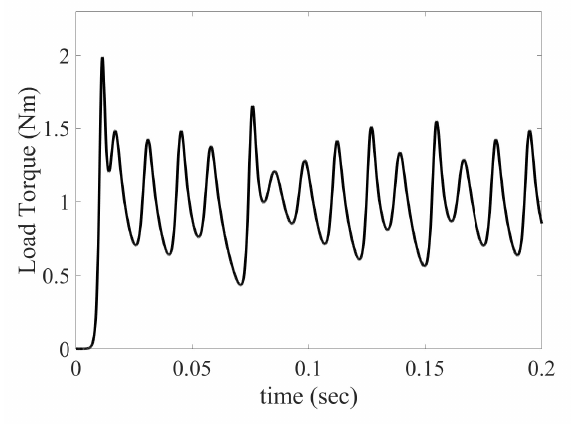
Figure 7. Random perturbation load torque applied to the PMSM.